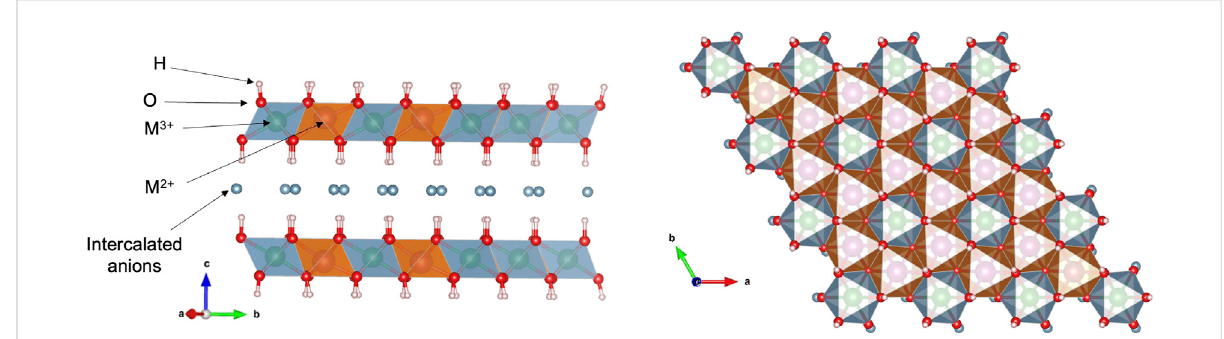
FIGURE 1 Schematicrepresentation of the structure of agenerictraditional layered double hydroxides(LDH) orthogonally and along the crystallographic axis c, depicting the distorted octahedral sheets. The fi gures of structural models have been constructed using VESTA software (Momma and Izumi, 2011; Leal et al., 2022). Reproduced from (Leal et al., 2022) with permission from